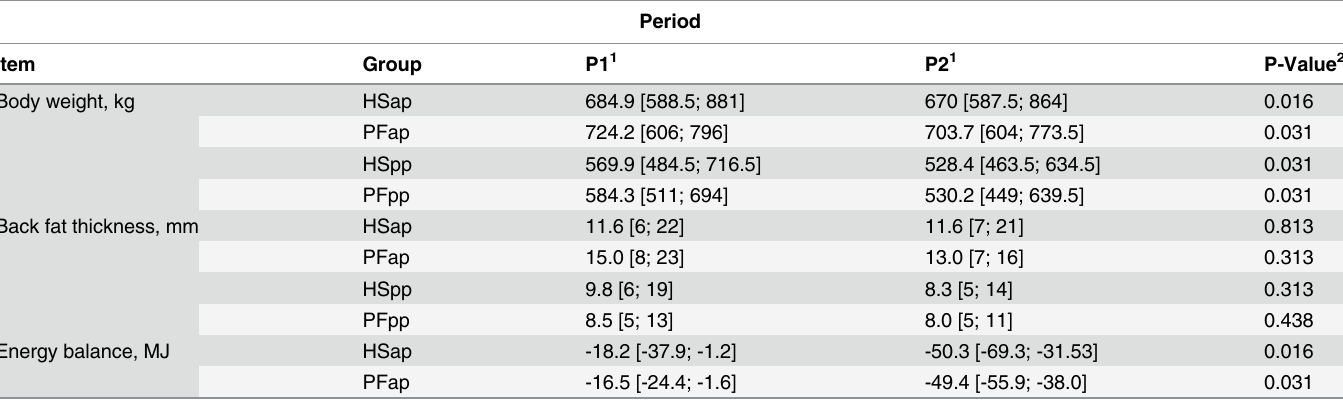
Table 1. Zootechnical data and energy balance of heat-stressed (HS) and pair-fed (PF) cows.